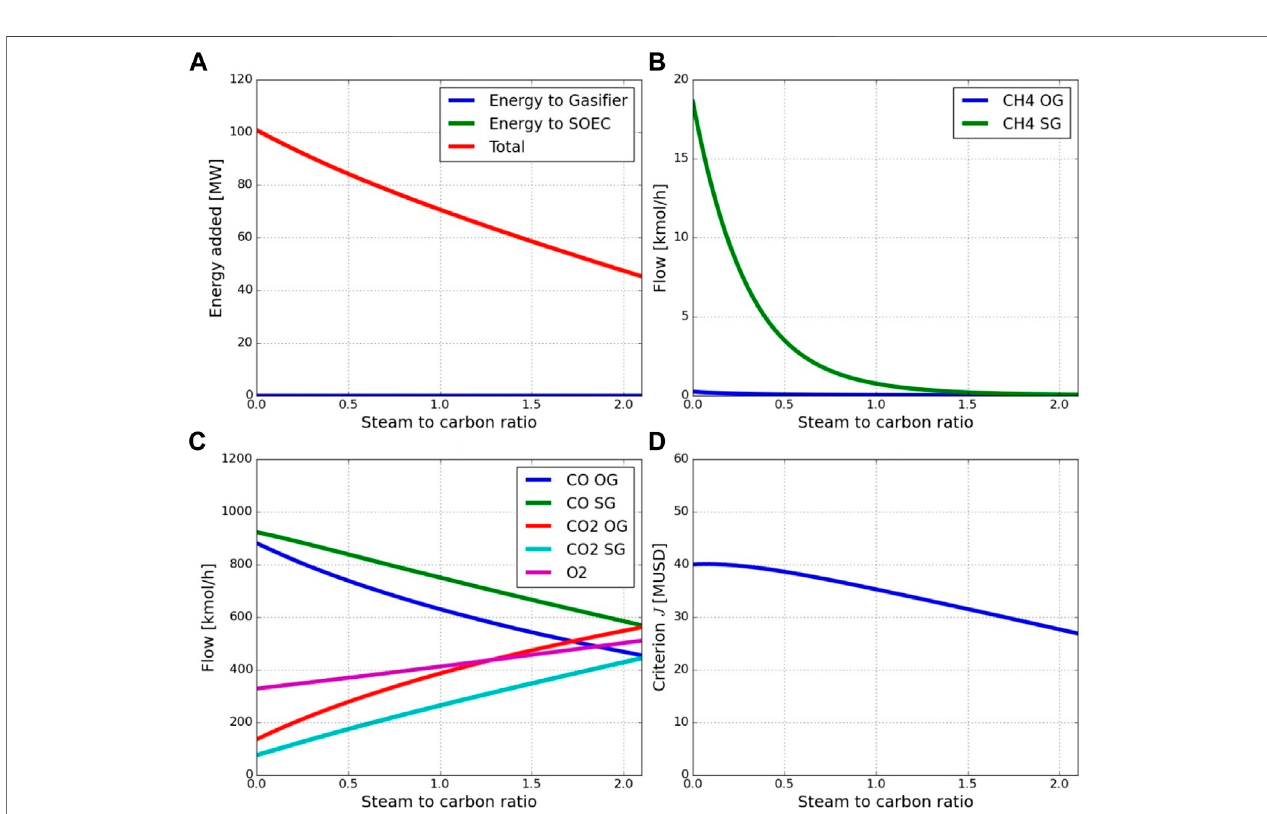
FIGURE 4 | The effect of the steam to carbon ratio without any extra energy added to gasifer on (A) the energy added to the SOEC, (B) the amount of methane present in gasi fi er outlet (OG) and in the syngas (SG), (C) the amount of CO and CO2 present in OG and SG and the amount of oxygen required to maintain the gasi fi er temperature of 1300 degC, and (D) the criterion de fi ned in Eq.